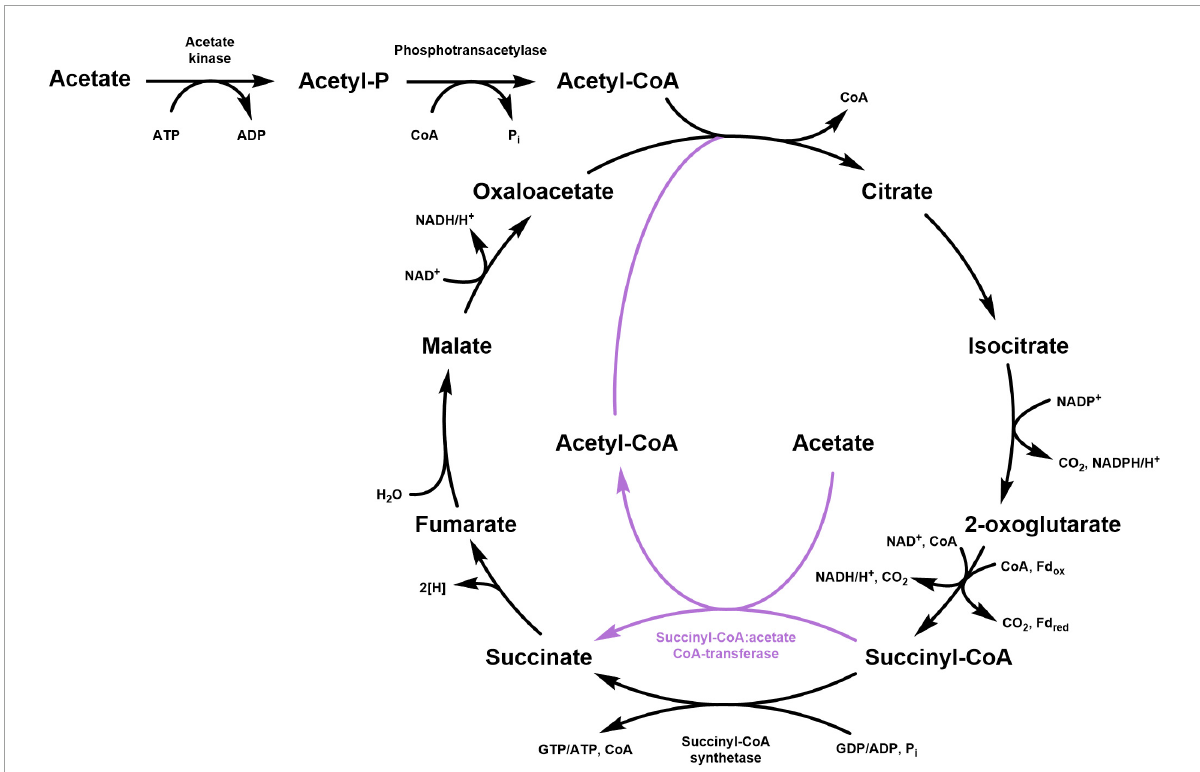
FIGURE1 Schematic representation of the classical TCA cycle (black) and its modification involving a succinyl:CoA:acetate CoA-transferase (purple). For the 2-oxoglutarate decarboxylation, both NAD-dependent 2-oxoglutarate dehydrogenase (aerobic and facultative anaerobic organisms) and 2-oxoglutarate:ferredoxin oxidoreductase (strict anaerobes) are